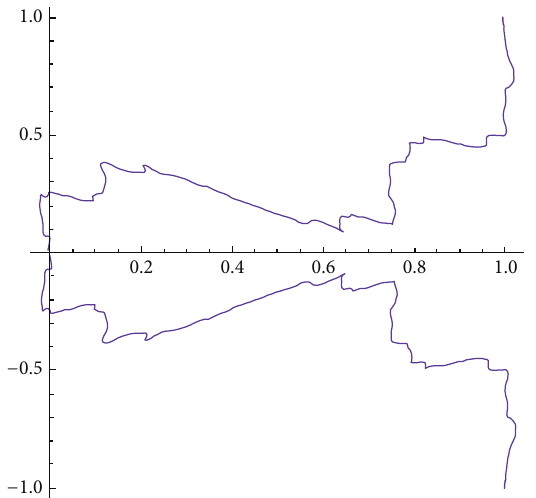
Figure 1: Fractal interpolation vector-function g ⋆ .